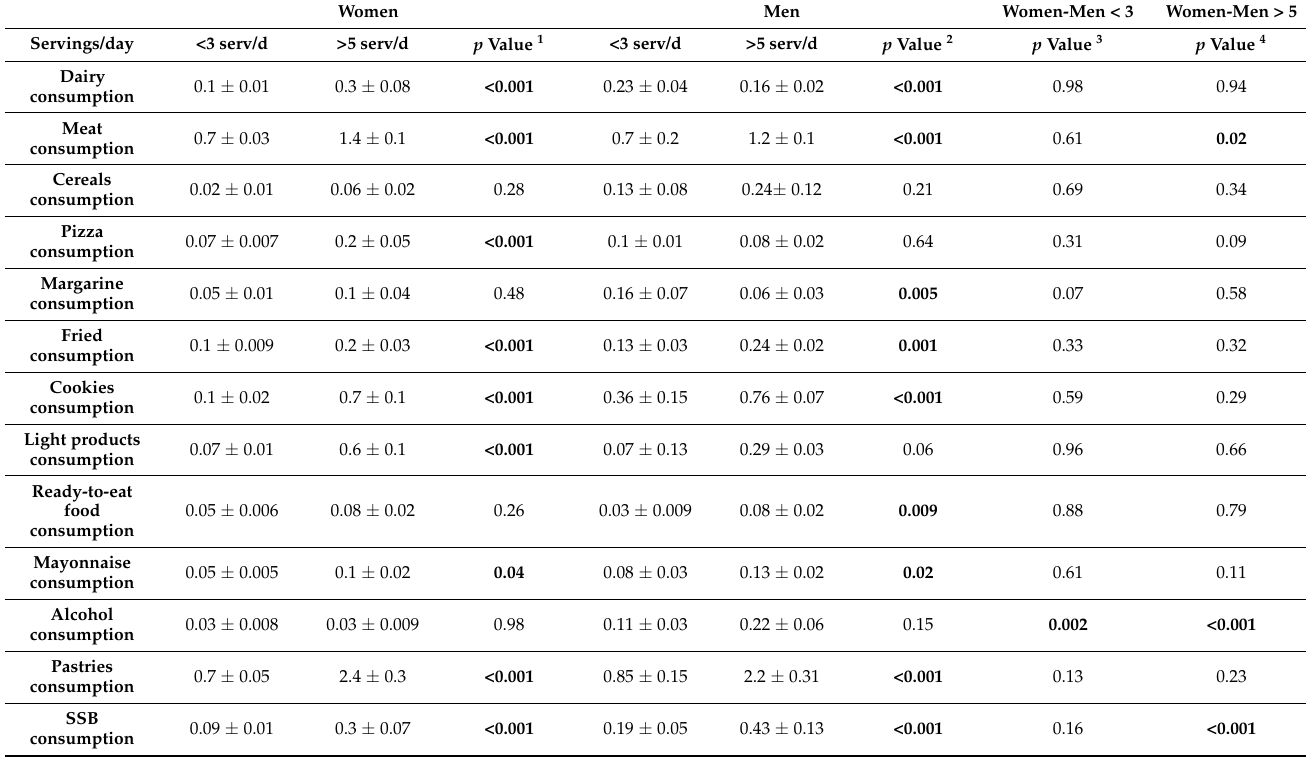
Table 2. Servings per day of the different groups of UPF separated by